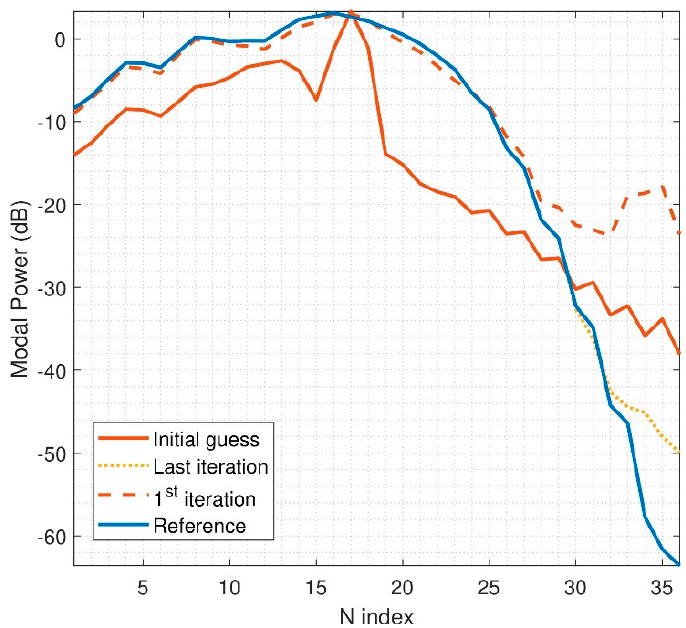
Figure 7. N ‐ power spectrum of reconstructed field, r 0 = 8 λ , d = 6 λ , 2 arch rotations. Figure 7. N-power spectrum of reconstructed field, r